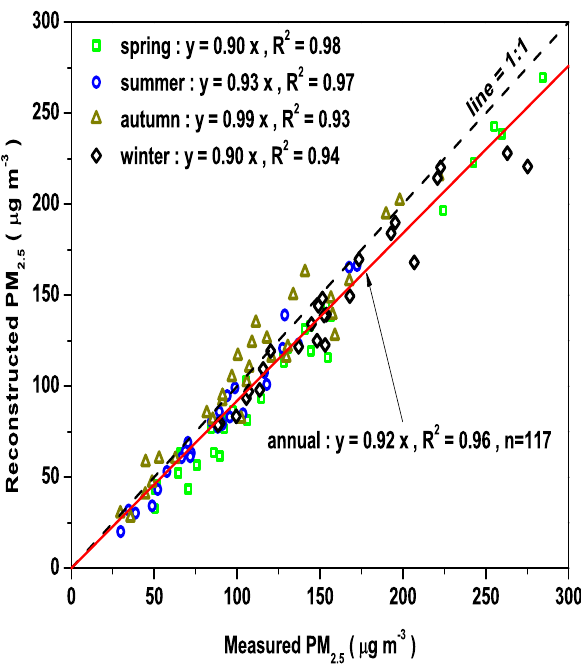
Figure 4. Correlation between reconstructed and measured PM 2 . 5 mass concentrations in four seasons. Also shown are the linear re- gression lines with regression equations. Figure 5.